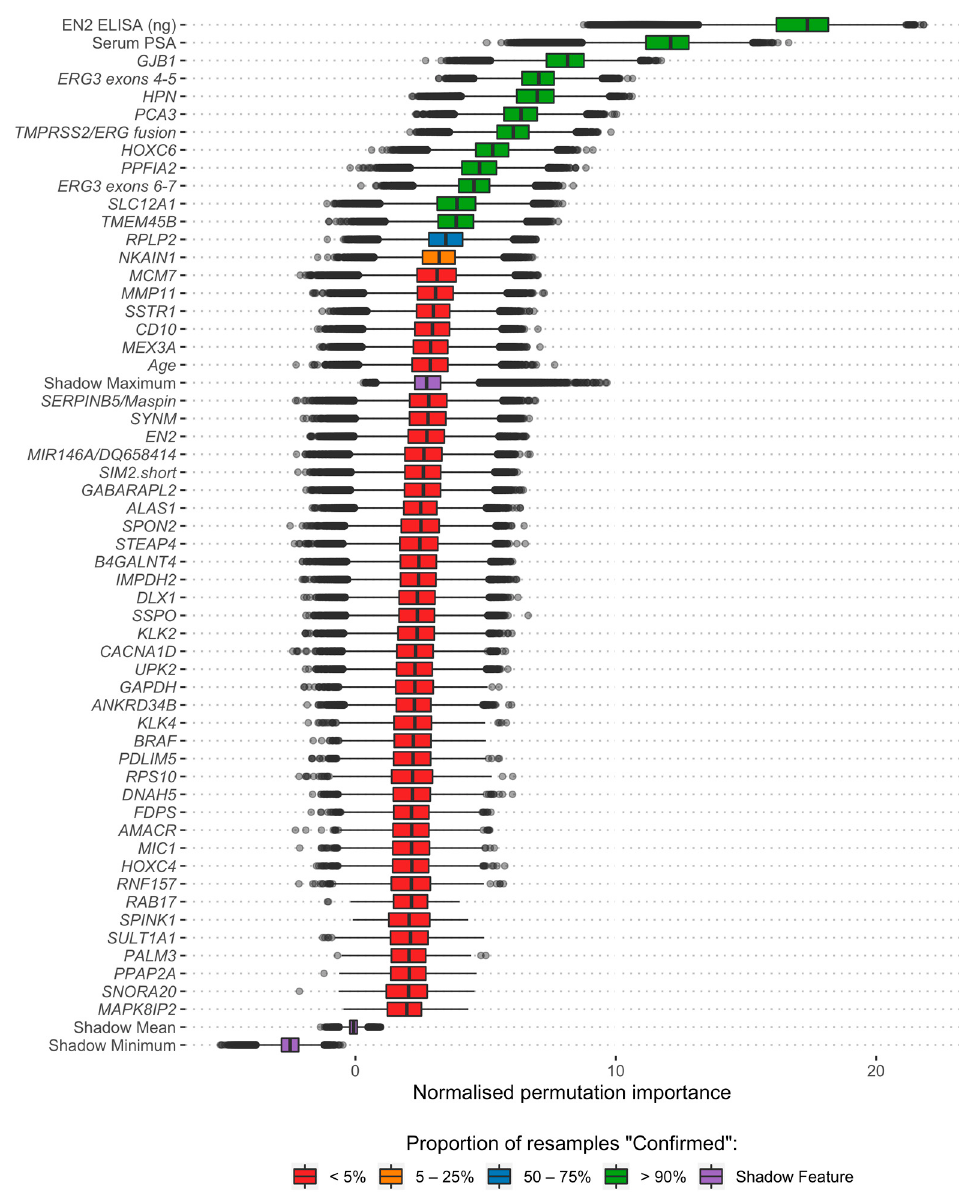
Figure 1. Analysis of variables available for the training of the ExoGrail model through the application of the Boruta algorithm via bootstrap resampling. 1000 resamples with replacement of the available data were made, with the normalised permutation importance of each variable recorded at each iteration, along with the decision of Boruta within that resample. Fill colour shows the proportion of resamples that a feature was positively retained by Boruta. Those features selected in ≥ 90% of resamples were selected for fitting predictive models. Variables rejected in all of the 1000 resamples are not shown here but are fully detailed in Table S1.